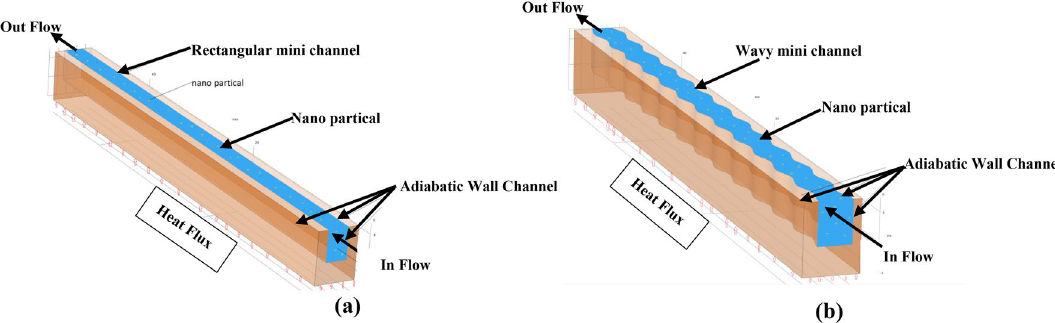
Figure 1. Schematic diagram of a present problem ( a ) conventional channel ( b ) wavy